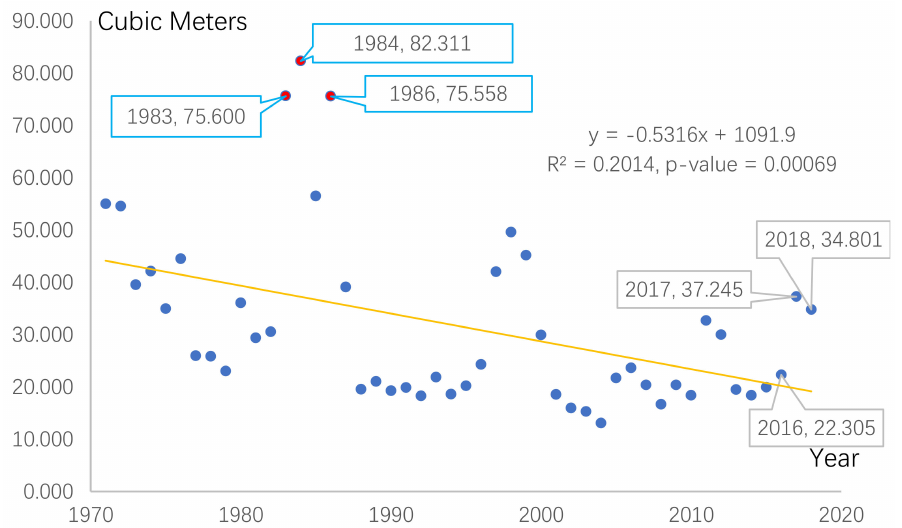
Figure 4. Surface inflows from Bear River and Jordan River into Great Salt Lake from 1971 to 2018. Data source: